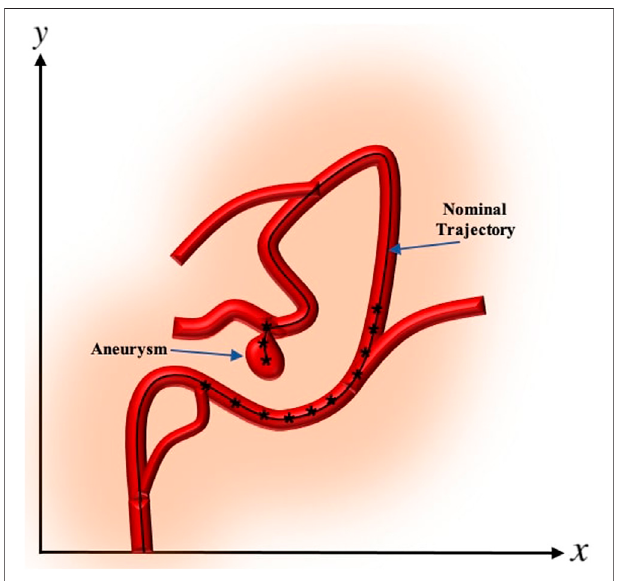
FIGURE 4 | The nominal trajectory and the nominal points generated along a vessel with aneurysm.